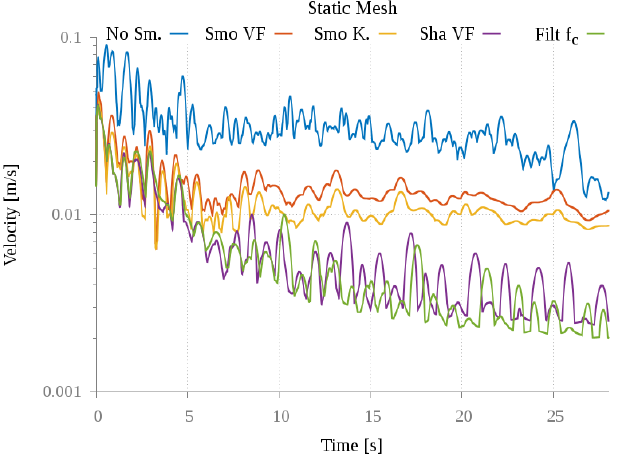
Figure 1. Maximum velocity in the domain over